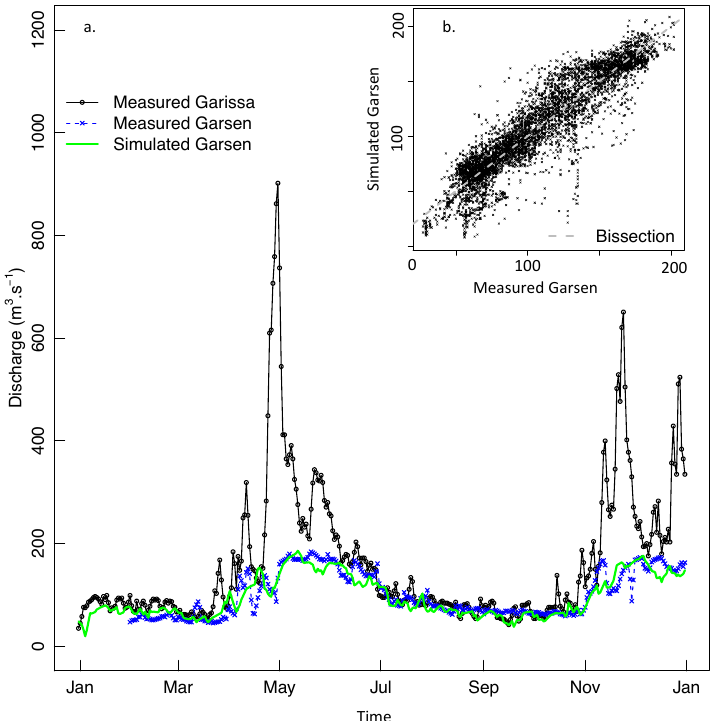
Fig. 2. (a) Example of measured discharges at Garissa, Q 1 , and Garsen, and simulated discharge at Garsen, Q 2 , in 1988. (b) Simulated versus measured discharge at Garsen for the validation periods (1963–1986 and 1991–1998).